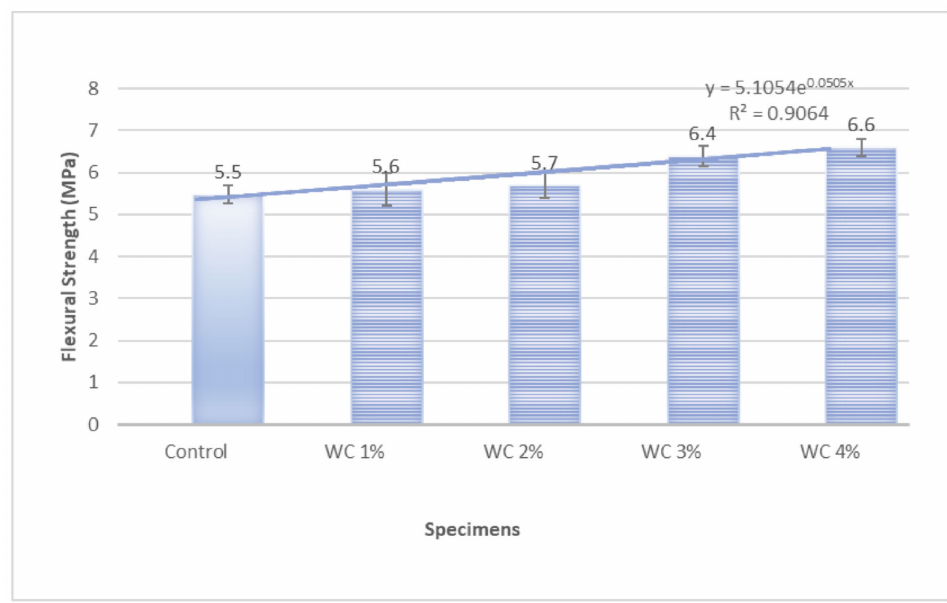
Figure 7. Flexural Strength Variation with the increase in WC